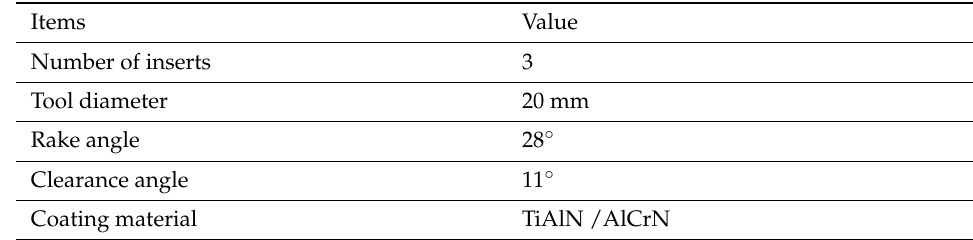
Table 2. Cutting tool and end mill insert geometry [18].